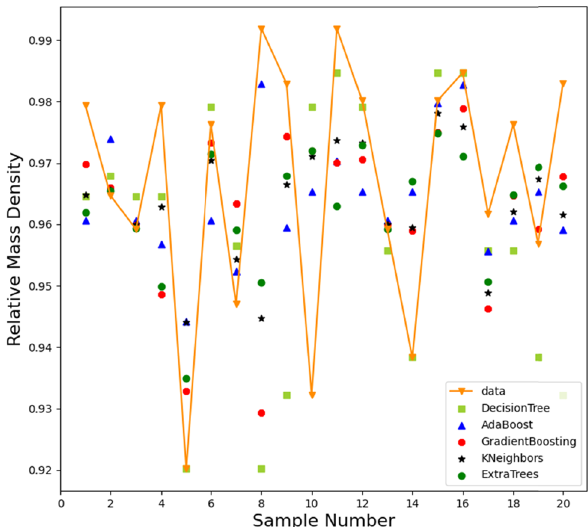
Figure 14: Relative mass density prediction of CNTs/AlSi10Mg nanocomposites using di ff erent ML methods with PCA decomposi - tion reduced features.